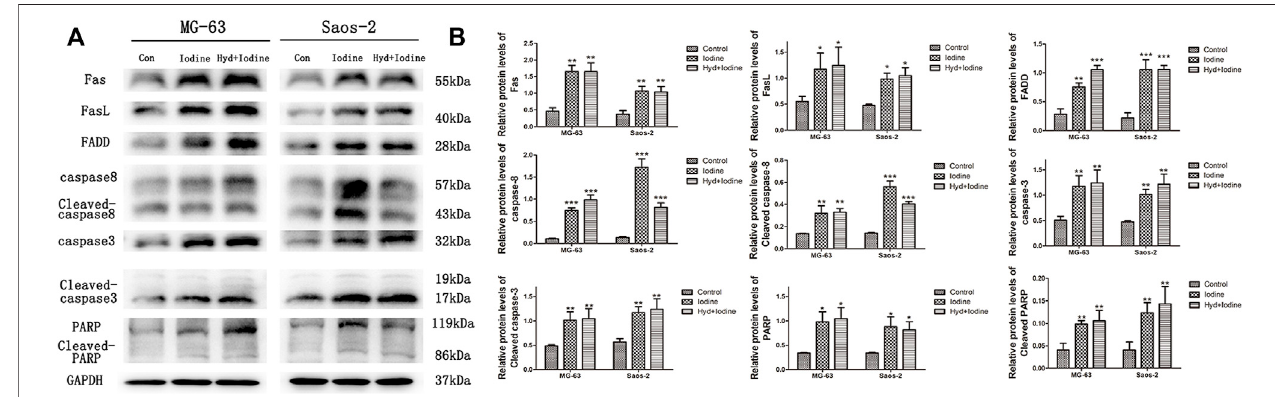
FIGURE 5 | Iodine induces apoptosis through the death receptor pathway. (A) A representative Western blot of Fas, FasL, FADD, caspase-8, cleaved caspase-8, caspase-3, cleaved caspase-3, PARP and cleaved PARP in protein extracts of MG-63 and Saos-2 cells pretreated with iodine and released iodine solution for 12 h. (B) Densitometric analysis of Fas, FasL, FADD, caspase-8, cleaved caspase-8, caspase-3, cleaved caspase-3, PARP and cleaved PARP levels. The results are presented as the mean ± SD ( n = 3) (* p < 0 0.05, ** p < 0 0.01, *** p < 0 0.001) (SD: standard deviation).